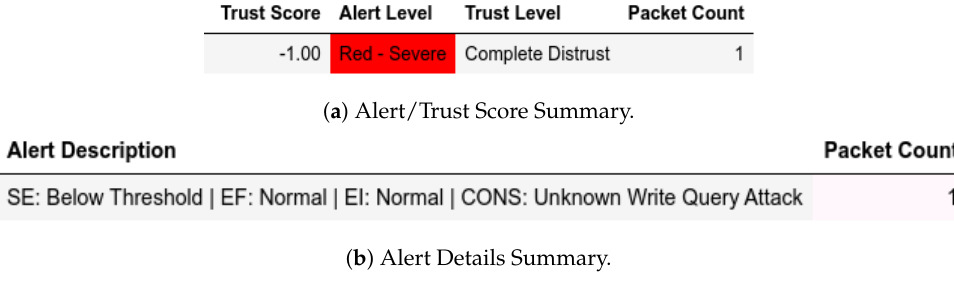
Figure 14. Server: EPM dataset internal test- H (cid:48) in send-fake-command attack scenario.